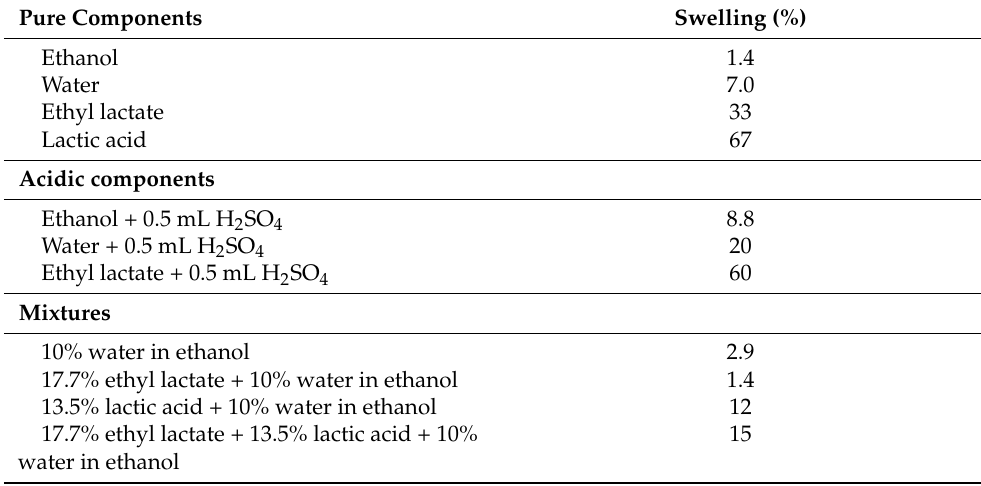
Table 1. Degree of swelling calculated as the change of weigh of a piece of membrane incubated for 15 days at 60 ◦